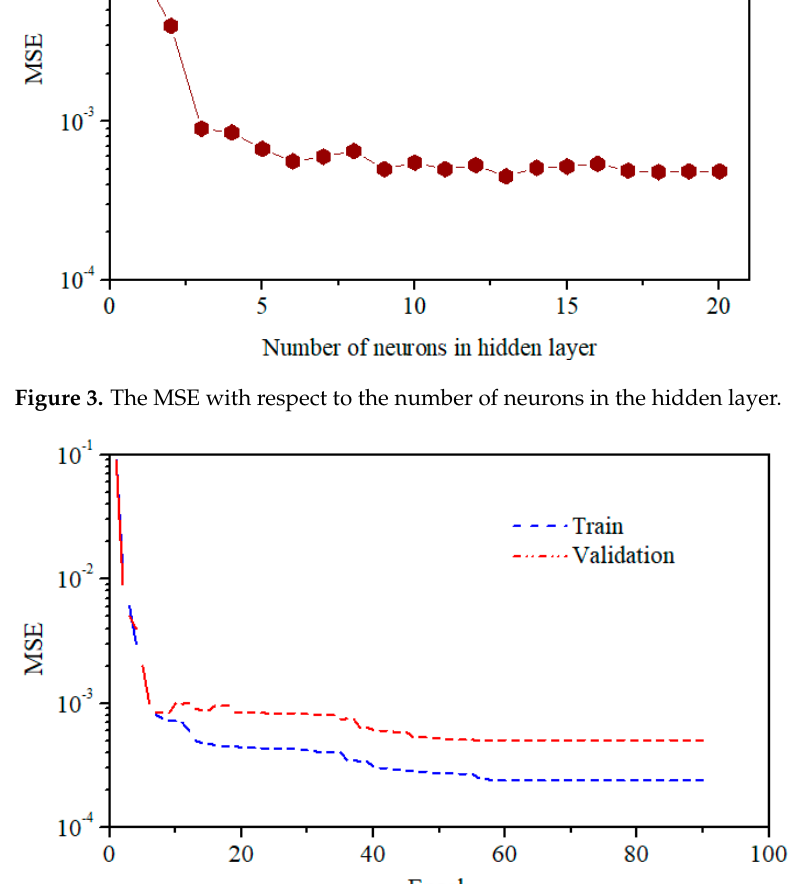
Figure 4. Effect of epochs on MSE in the process of network